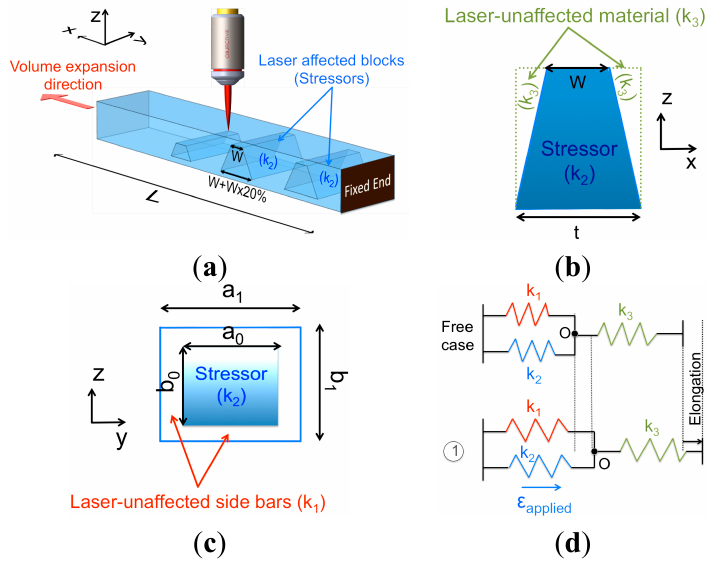
Figure 9. ( a ) Side view of the laser-affected bars that load the tensile tester. Optimized pattern structure of the sequential scanning of stressors for achieving uniform loading conditions. ( b ), ( c ) Parameters used to describe a single stressor. ( d ) Simplified spring model of the loading process.